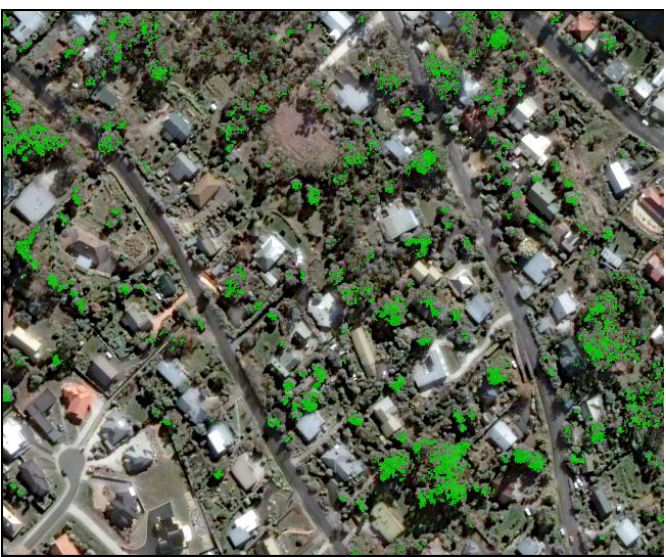
Figure 6. Training sample of tree class (parrot green) within a sample area of the 2005 image using the normalised di ff erence vegetation index (NDVI) and canopy height model (CHM) thresholds. Table 3. List of the number of objects, maximum and minimum canopy height model (CHM) and normalised di ff erence vegetation index (NDVI) values from iterative segmentation with di ff erent scale factors. The maximum and minimum values of CHM and NDVI did not change beyond scale factor 2. Scale